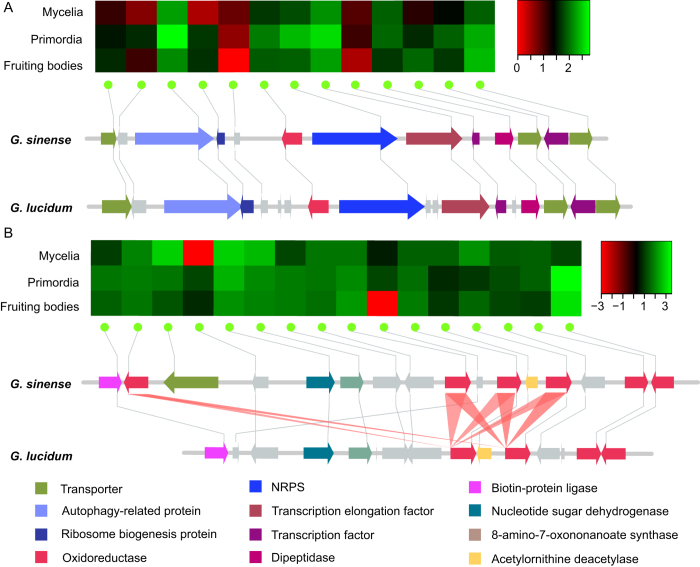
Secondary metabolism gene clusters and their expression.A) NRPS gene clusters and their expression profiles across three different developmental stages: mycelia, primordia and fruiting bodies. The heatmap shows the Log10 (RPKM) values as colors increasing from red to black to green. The different colors in the gene clusters of G. sinense and G. lucidum represent the different types of genes. B) CYP gene clusters and their expression profiles. The red triangles connect the CYP5139 homologous genes between G. sinense and G. lucidum.